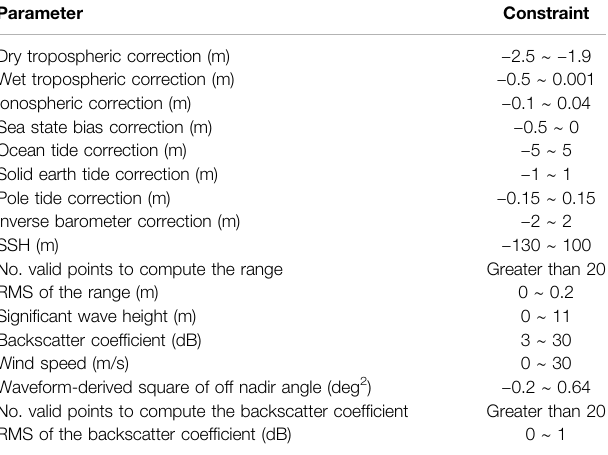
TABLE 1 | Selection criteria for SSH